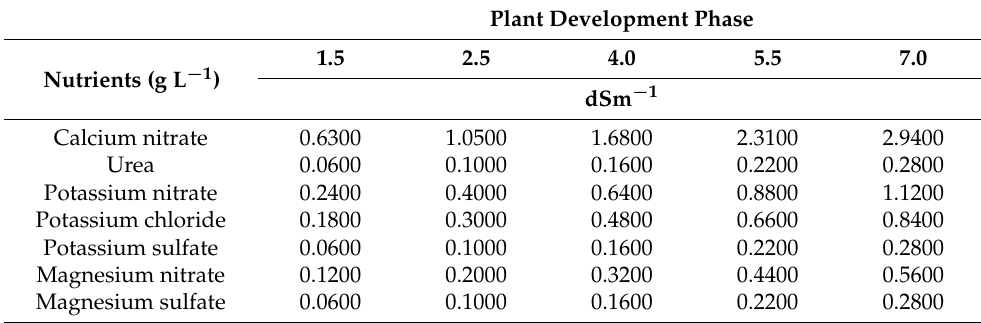
Table 1. The concentration of fertilizers diluted in water for fertigation